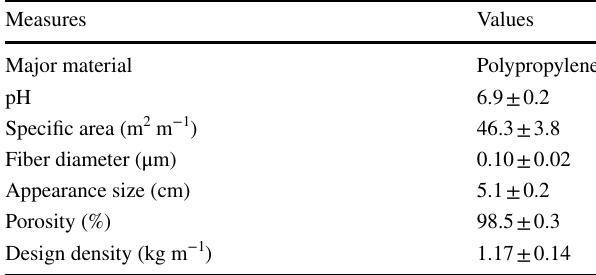
Table 2 Measures of the experimental fillers of the floating